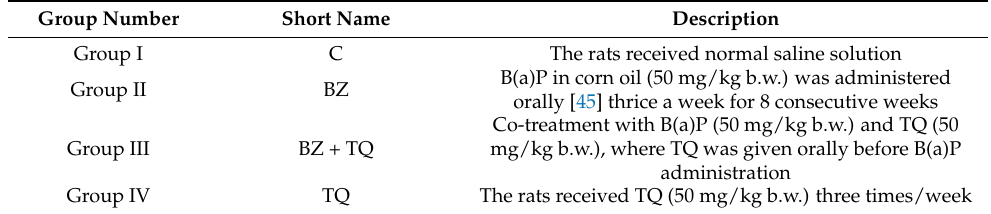
Table 1. Animal grouping and treatment